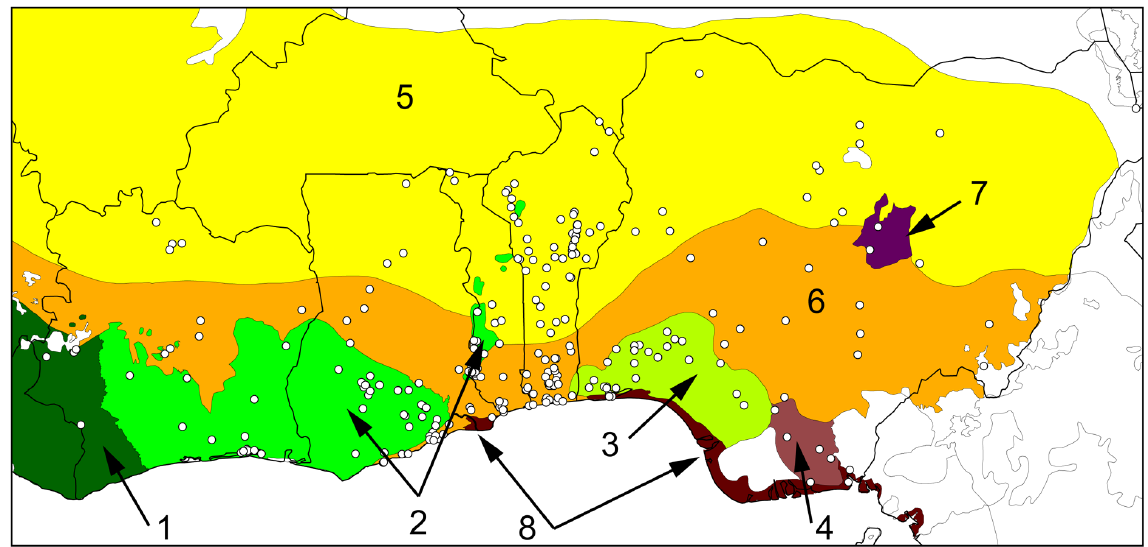
Fig. 2. Ecoregion boundaries of West Guinean Lowland Forest (1), East Guinean Forest (2), Nigerian Lowland Forest (3), Cross-Nigerian Transition Forest (4), West Sudanian Savannah (5), Guinean Forest Savannah Mosaic (6), Jos Plateau Forest Grassland Mosaic (7), Central African Mangroves (8), with sites of collecting events for Tephritidae (open